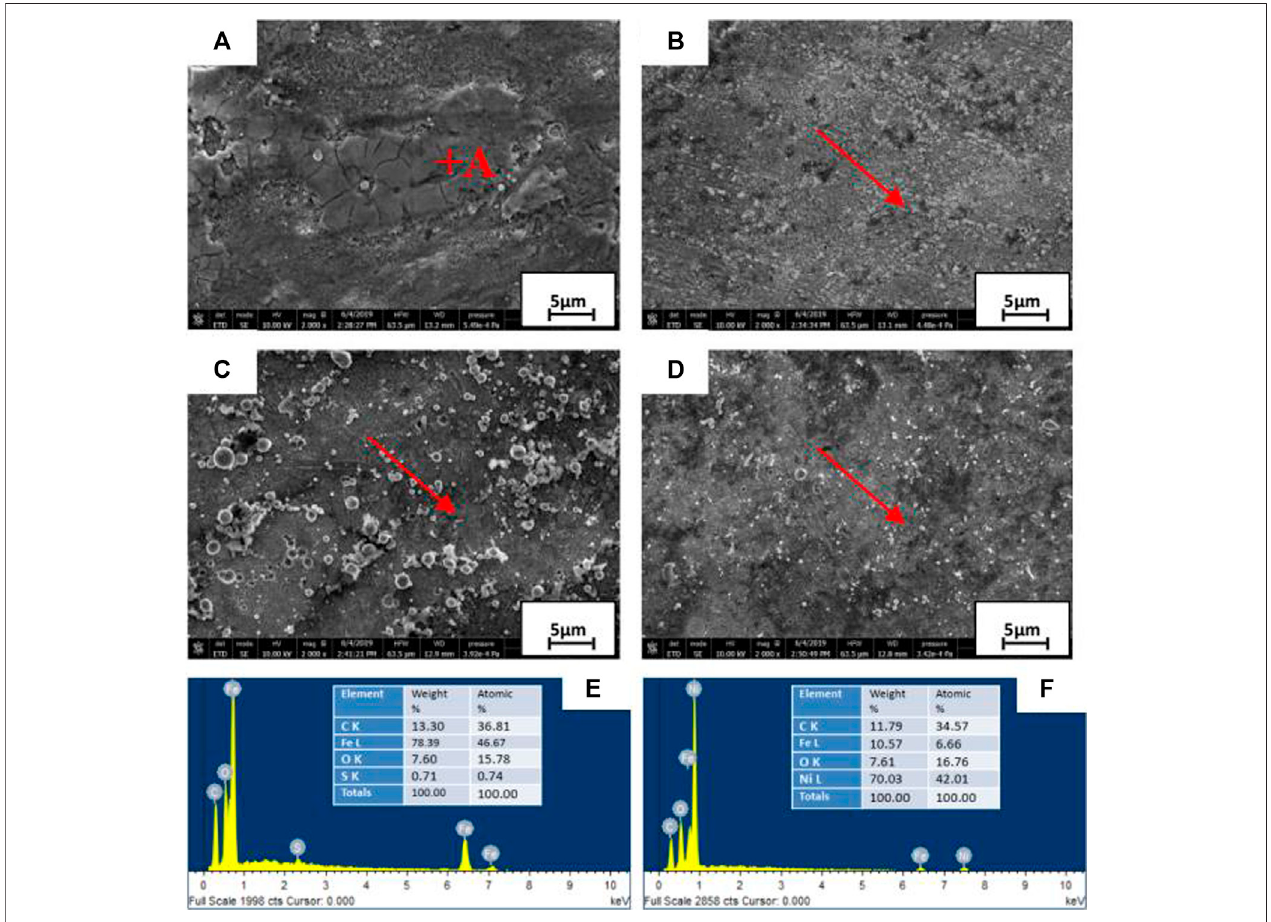
FIGURE14| SEMandEDSofFSWjoint (A) ,Nicoatings[50%dutyratio (B) ;80%dutyratio (C) ;100%dutyratio (D) ],andEDSelements[FSWjoints (E) ;Nicoating surfaces (F) ] after 24-h immersion in simulated seawater.